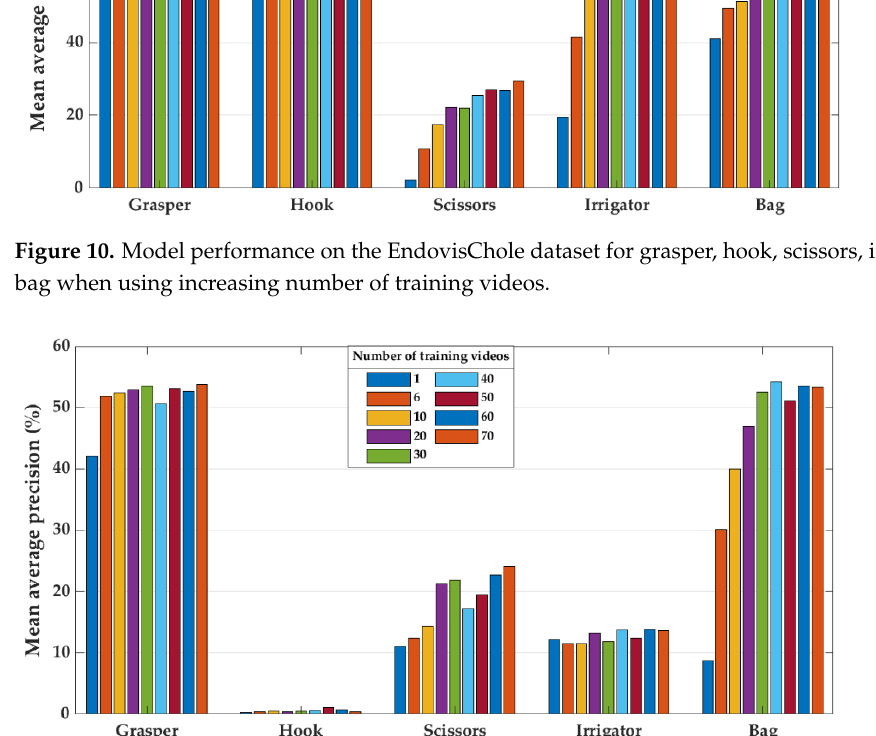
Figure 11. Model performance on the Gyna08 dataset for grasper, hook, scissors, irrigator, and bag when using increased number of training videos.